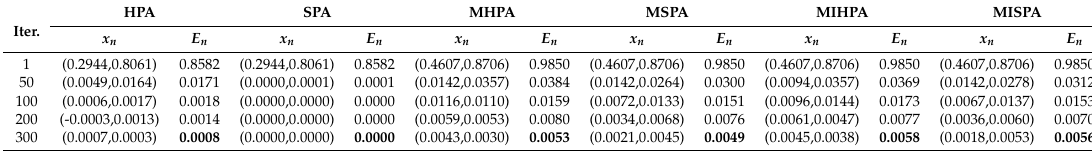
Table 2. Computational results for Example